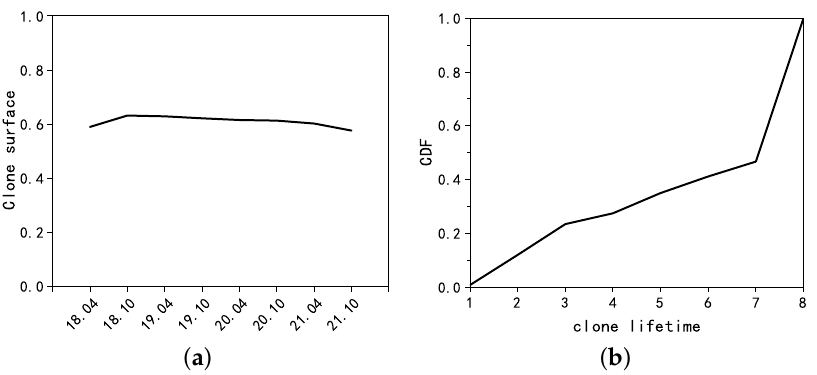
Figure 5. The clone surface and clone lifetime in the Linux clone landscape. ( a ) The clone surface for Linux. ( b ) The CDF for the clone lifetime in